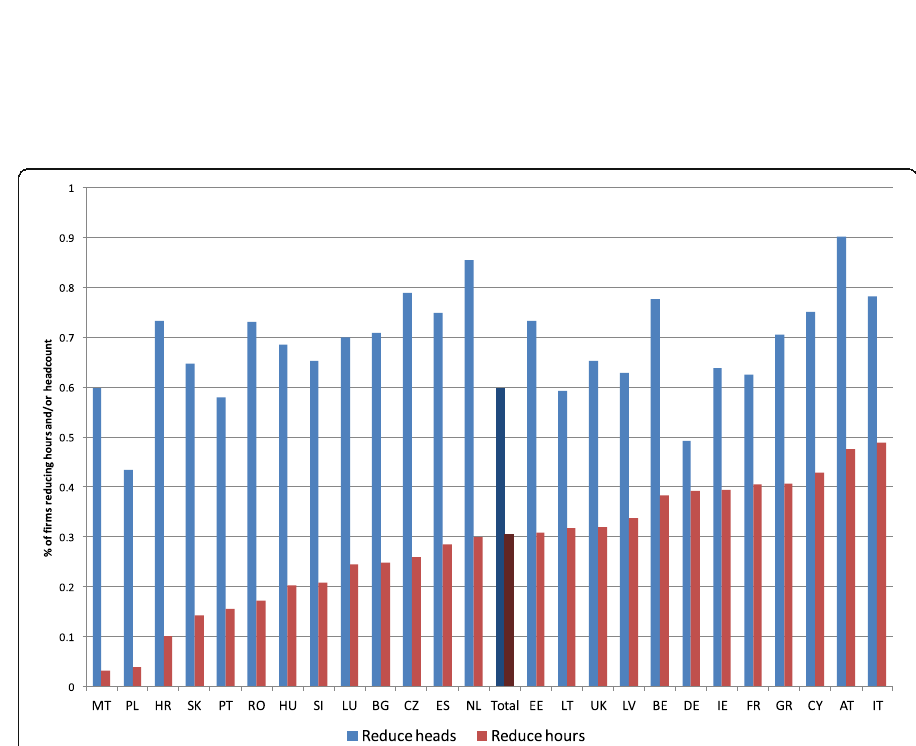
Fig. 2 Percentage of firms reducing hours or headcount, conditional on reducing labour costs, in 2010 – 2013. Note: Weighted by the number of firms in the firm